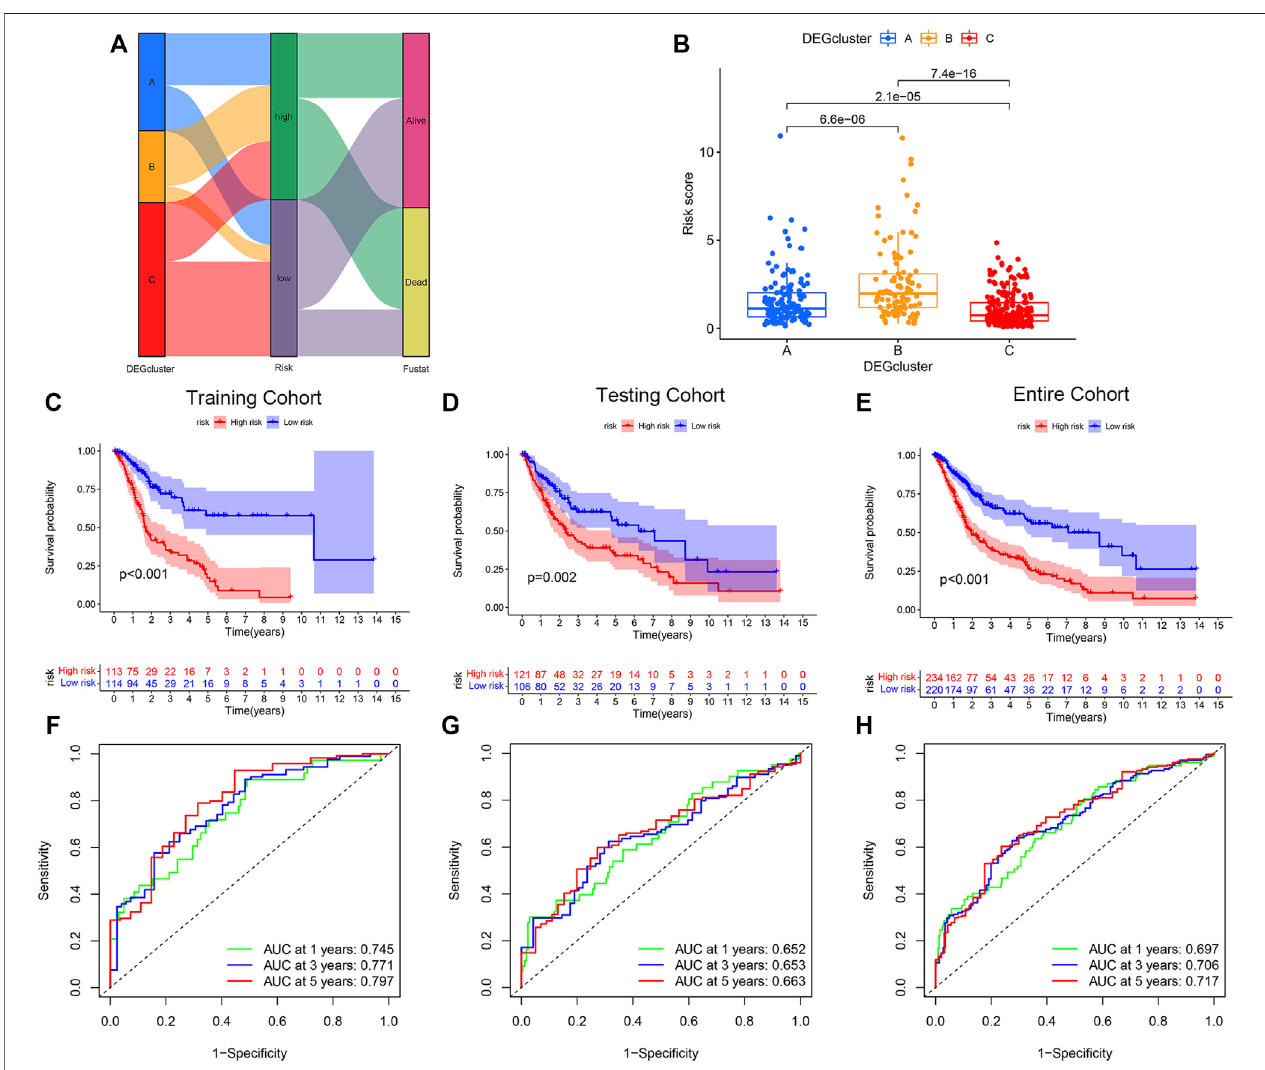
FIGURE3| Constructionandvalidationofthepyroptosis-relatedgenes(PRGs)riskscoremodel. (A) Sankeydiagramofthebladderurothelialcarcinomariskscore model constructed network. (B) Comparison of the risk scores of DEGcluster subtypes. Overall survival of patients with high- or low-PRG risk scores in the (C) training, (D) testing, and (E) the entire cohort. Receiver operator characteristics (ROC) curves of the risk score models for the (F) training, (G) testing, and (H) the entire cohorts.